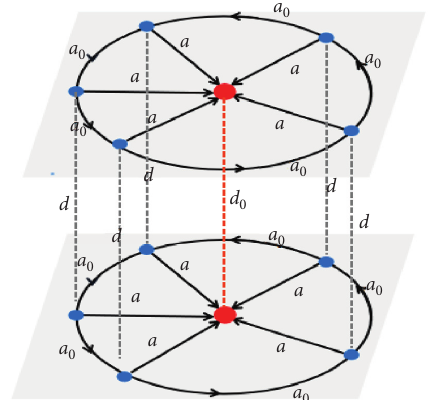
Figure 1: Schematic diagram of the structural model of Network